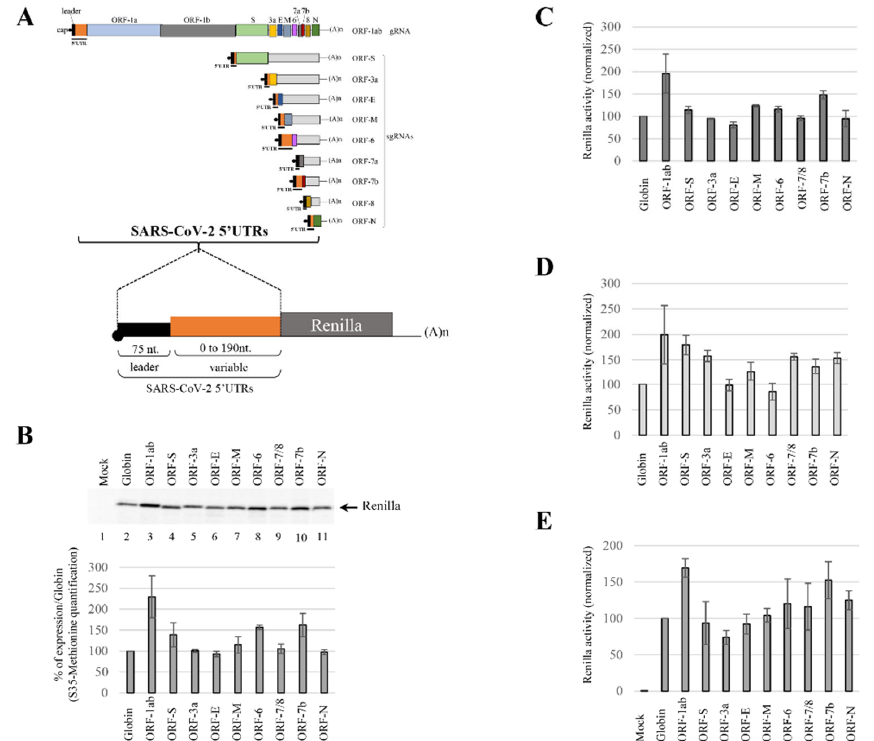
Figure 3. Translation efficiency of the SARS-CoV-2 5 (cid:48) UTRs. ( A ) Scheme of the gRNA and the different sgRNAs, with the leader sequence in black and the variable region in orange, which represent each 5 (cid:48) UTR (this panel was obtained from Figure 1). The sequences corresponding to each 5 (cid:48) UTR have been cloned upstream of the Renilla ORF. ( B , C ) RRL and ( D ) untreated RRL have been programmed with capped and polyadenylated mRNAs harboring specifically the 5 (cid:48) UTR of the ORF1ab, ORF-S, ORF-3a, ORF-E, ORF-M, ORF-6, ORF-7a, ORF-7b, ORF-8 or ORF-N. The resulting protein products have been resolved on ( B ) an SDS-PAGE and quantified with a phosphoImager, or ( C , D ) analyzed by luciferase assay. ( E ) Jurkat cells were electroporated with capped and polyadenylated mRNAs as indicated. After 90 min of incubation, the cellular extracts were used for RT-qPCR and luciferase assay. All the results are normalized to the globin 5 (cid:48) UTR expression (set at 100%). Values are the mean (+/ − S.D.) for three independent experiments (panels ( B , C )) or (+/ − S.E.M.) for four independent experiments (panels ( D , E